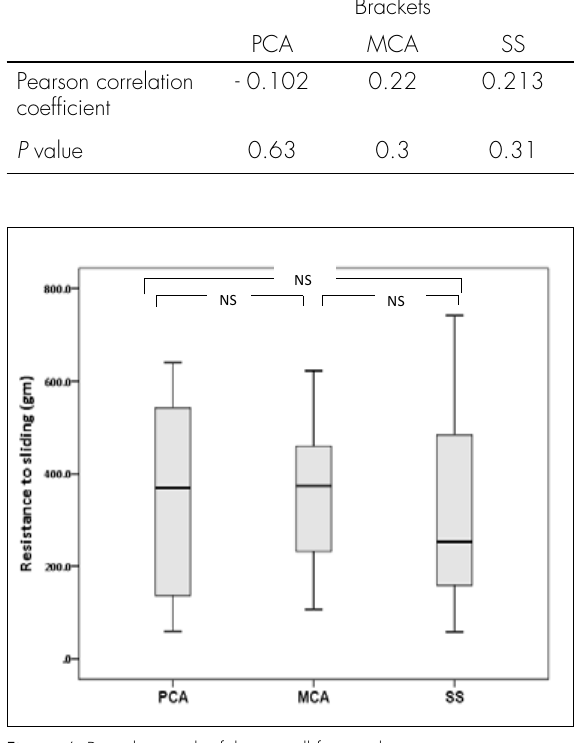
Figure 4. Box plot graph of the overall frictional resistance among bracket groups (wet environment). (PCA) polycrystalline alumina ceramic brackets. (MCA)